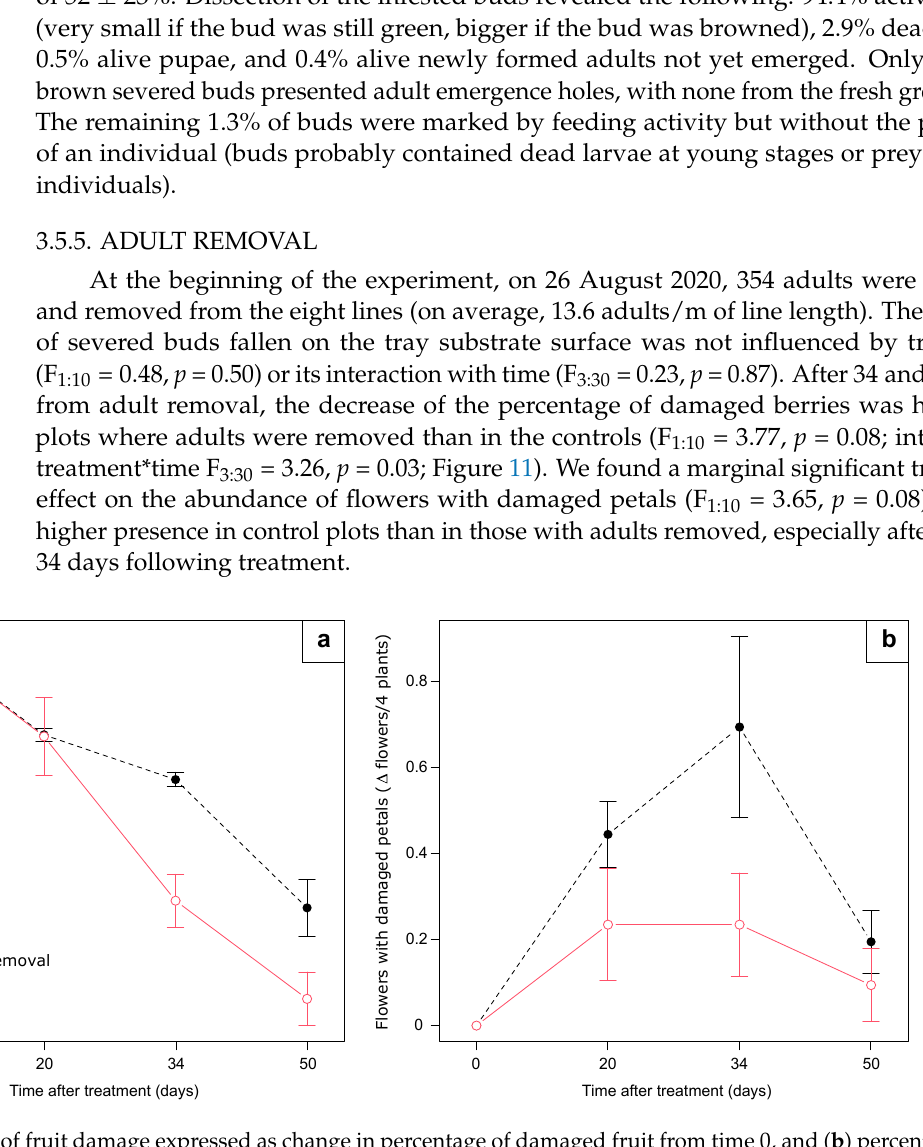
Figure 11. ( a ) Dynamics of fruit damage expressed as change in percentage of damaged fruit from time 0, and ( b ) percentage of flowers with damaged petals, expressed as percent change in flowers per 4 plants. Error bars indicate standard error.